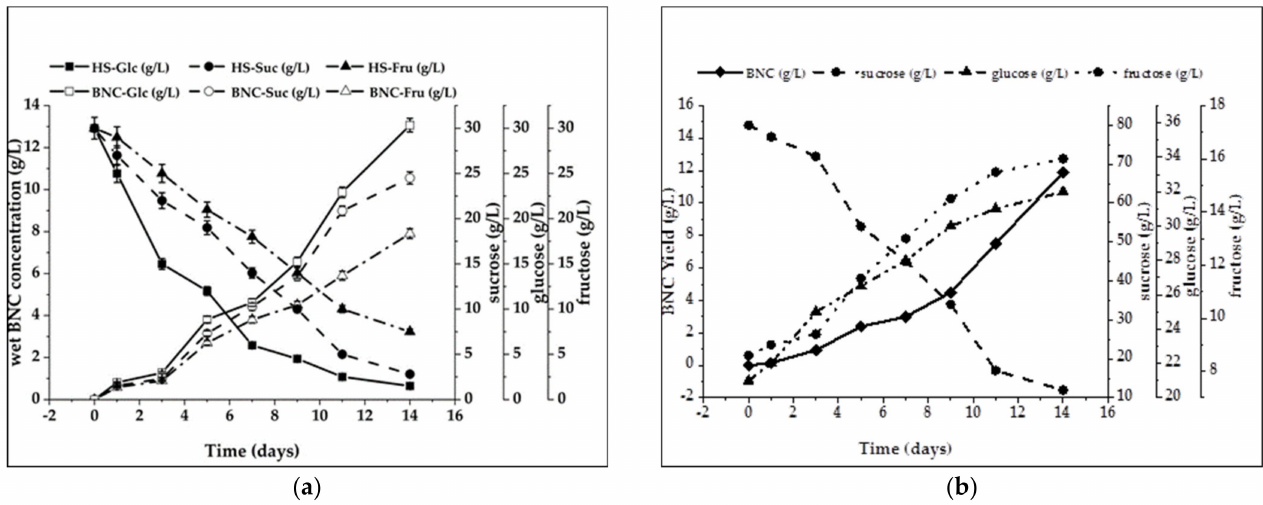
Figure 2. Dynamics of BNC synthesis: ( a ) modified HS media; ( b ) BTR